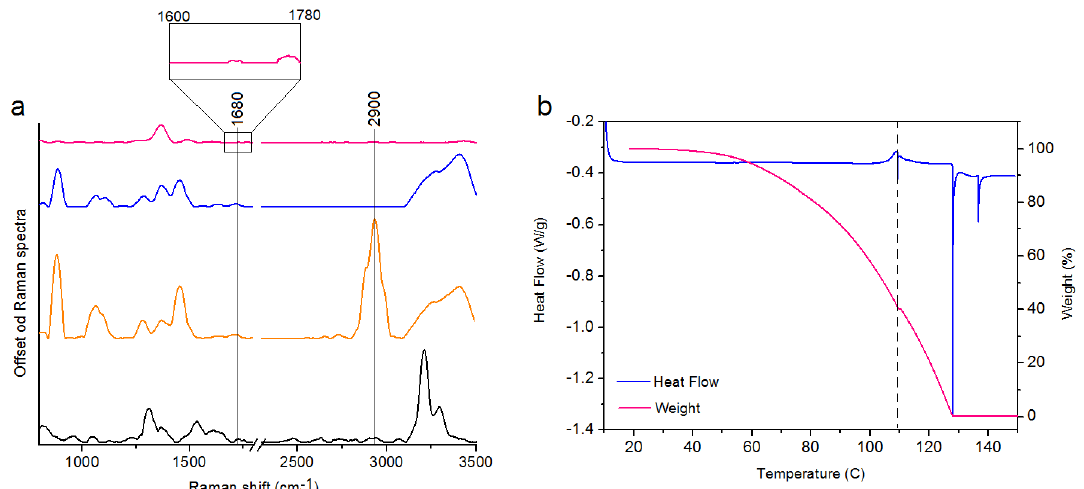
Figure 2. Raman spectra of: cPt (spectrum black), the pure MHDA (spectrum orange), the Au NPes + MHDA (spectrum blue), cPt@Au NPes (spectrum pink) ( a ); TGA and DSC data of cPt@Au NPes showing the solvent removal and decomposition of the product ( b ).